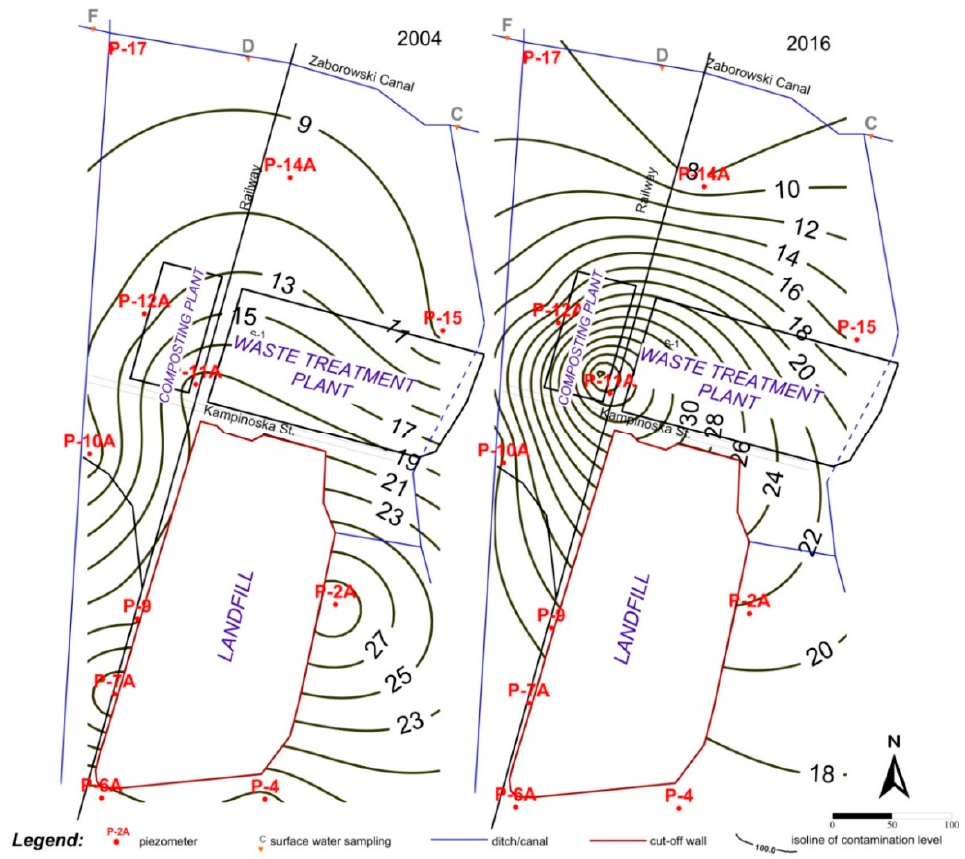
Figure 11. Distribution of the mean values of the total organic carbon (TOC) in groundwater in 2004 and 2016.